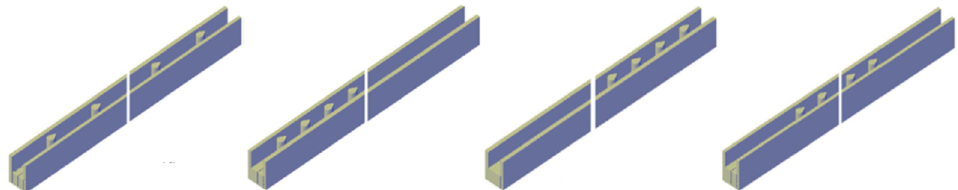
Figure 9. Distribution types of pin fin in channel [107]. Table 5. The effect of pin fins on the thermal and hydrological performance of